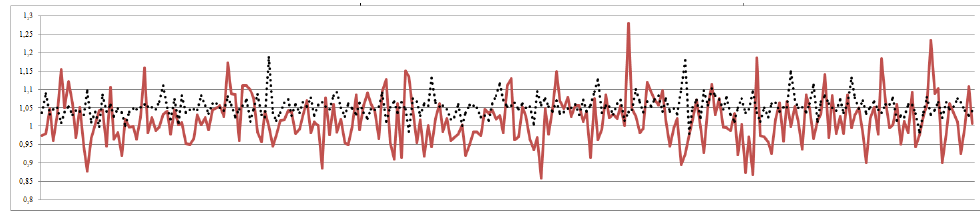
Figure 2. Values of the variables Δ M (continuous red line) and Δ I (broken black line) in the sample used.